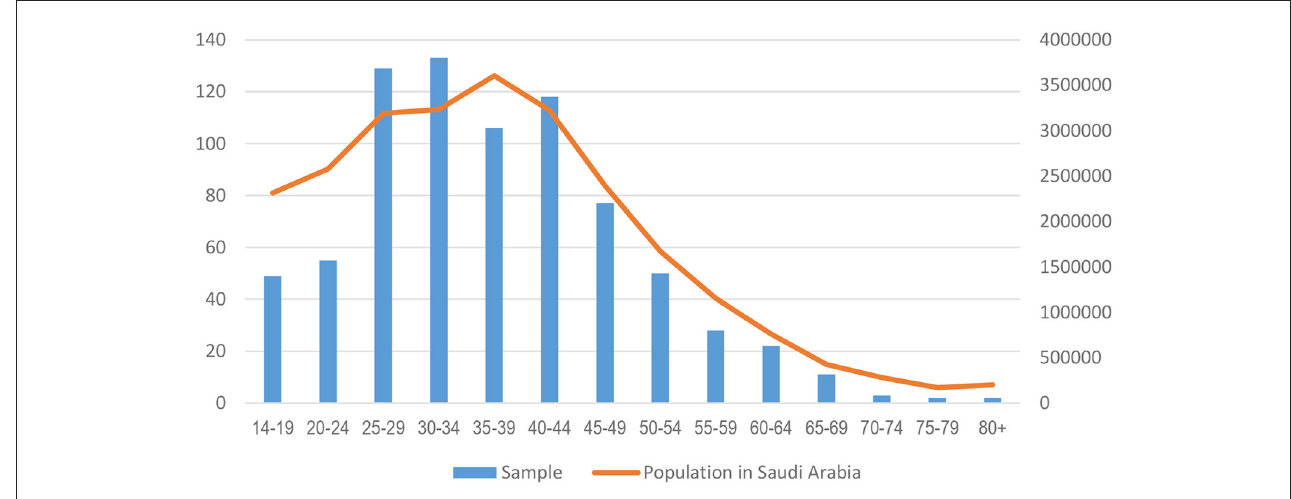
FIGURE1 Age of respondents (in years) compared to the estimated population in Saudi